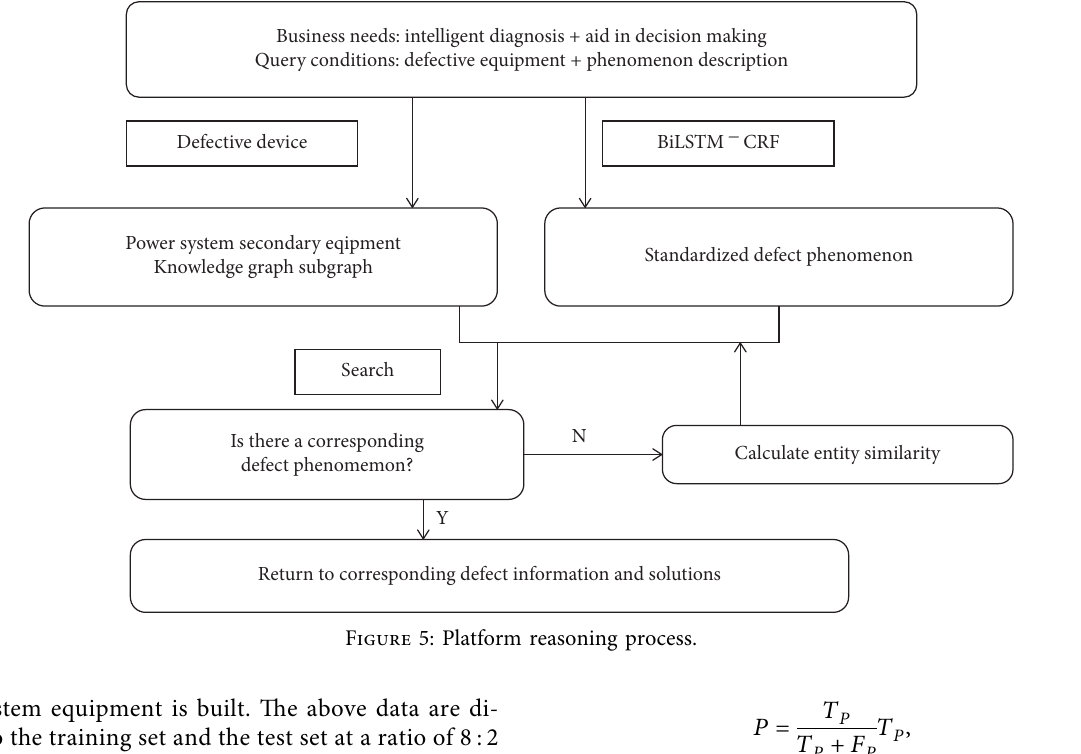
Figure 5: Platform reasoning